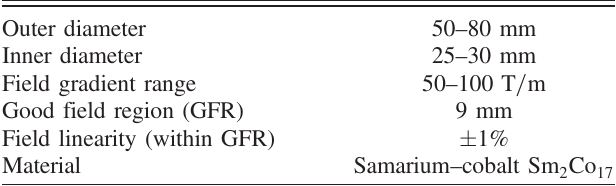
TABLE II. Target requirements for magnet designs. Outer diameter